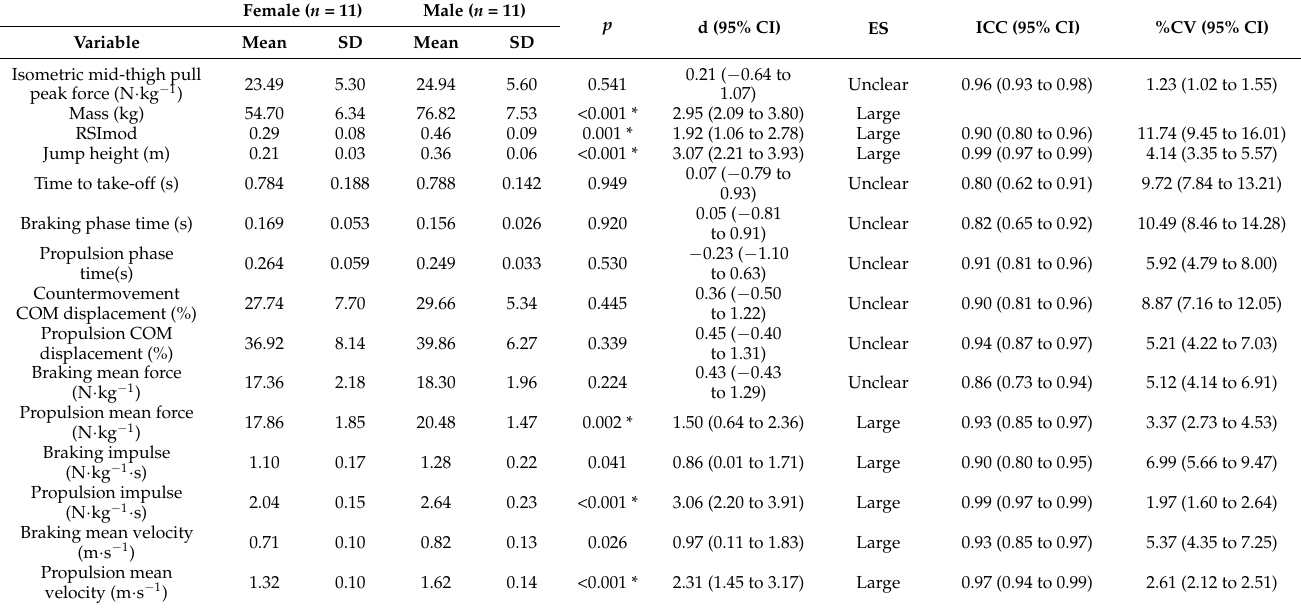
Table 1. Comparison of gross countermovement jump